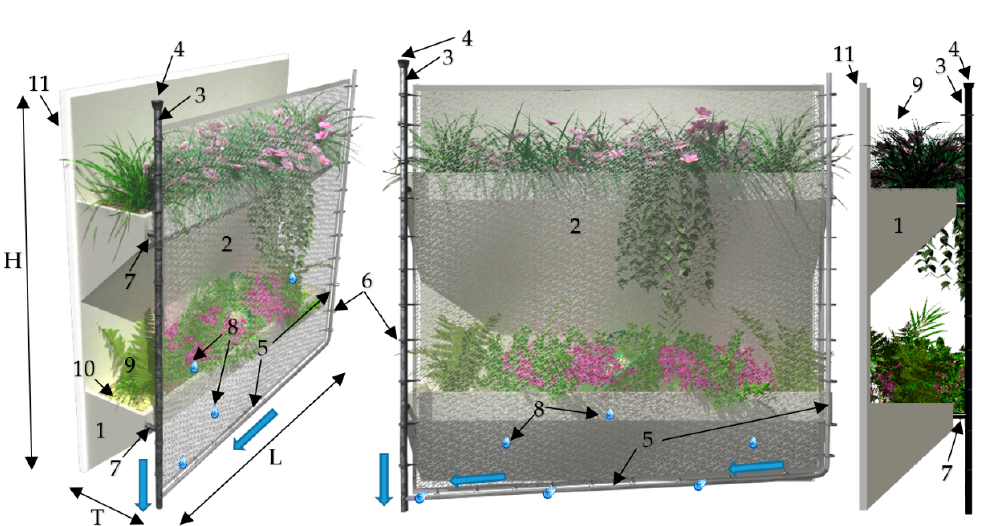
Figure 2. The novel living wall platform with a fog harvesting mesh. 1—living wall platform, 2—mesh